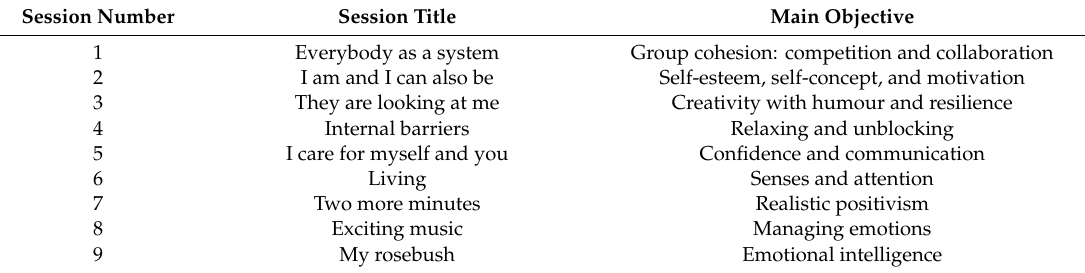
Table 1. Titles and objectives of the integrative laughter workshop